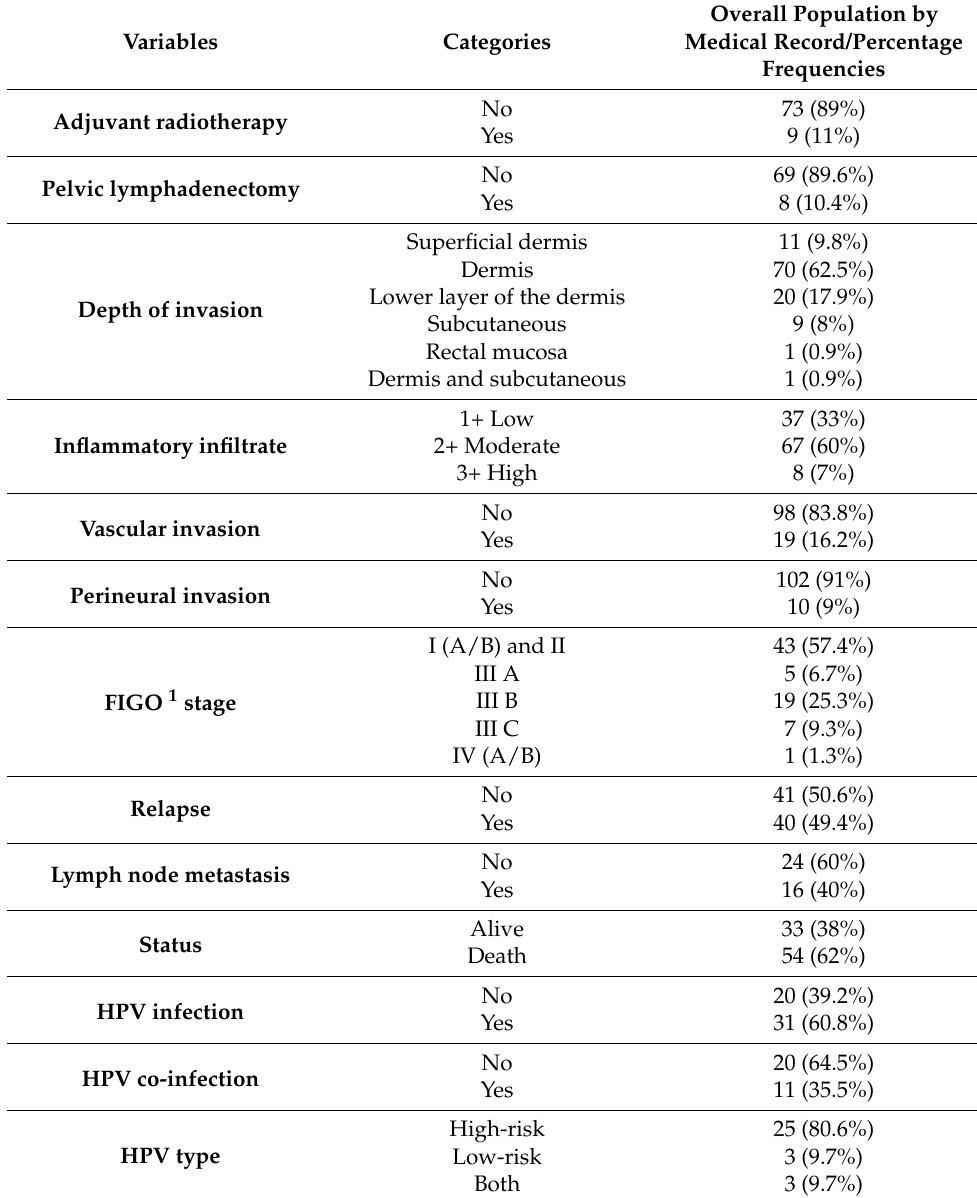
1 FIGO: International Federation of Gynecology and